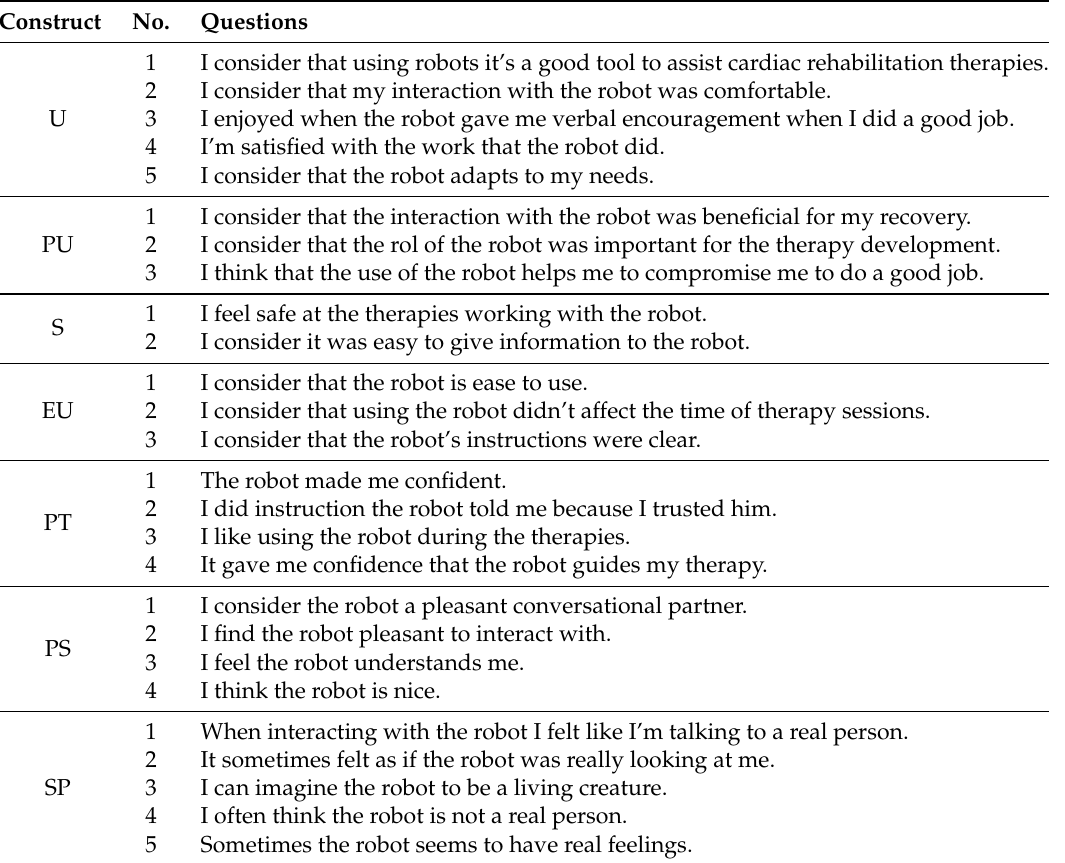
Table A1. Perception Questionnaire for Patients.